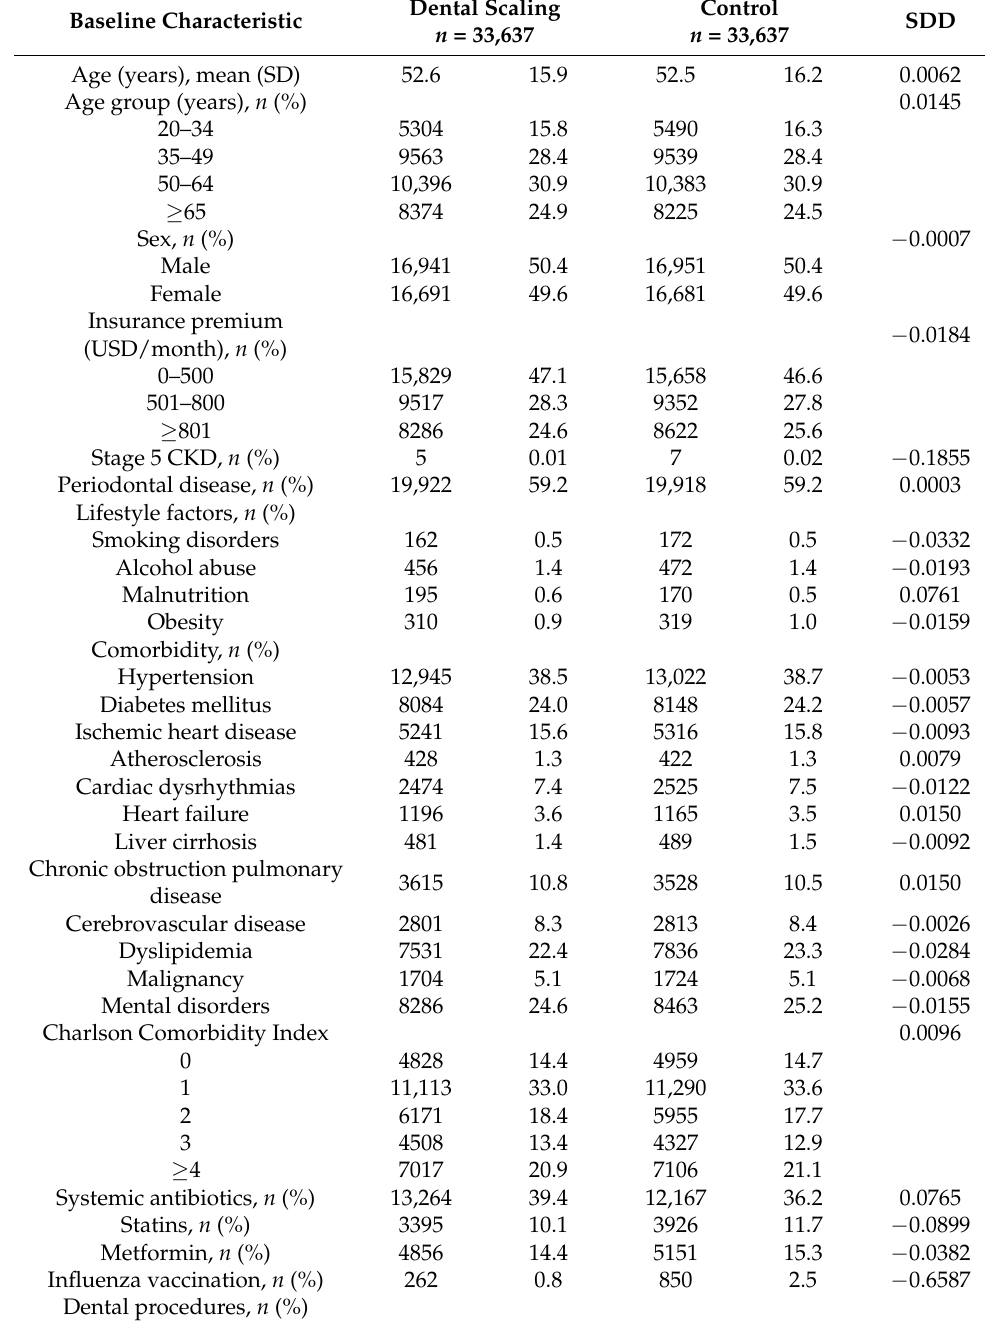
Table 1. Baseline characteristics of CKD cases with dental scaling treatment and matched